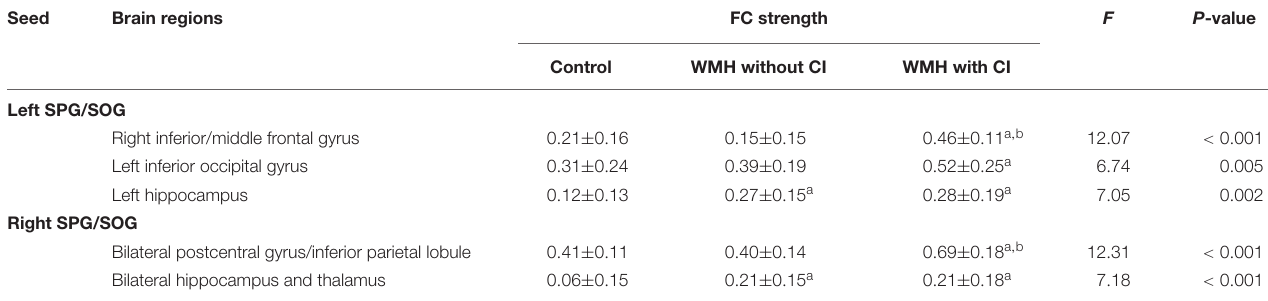
TABLE 3 | FC data.